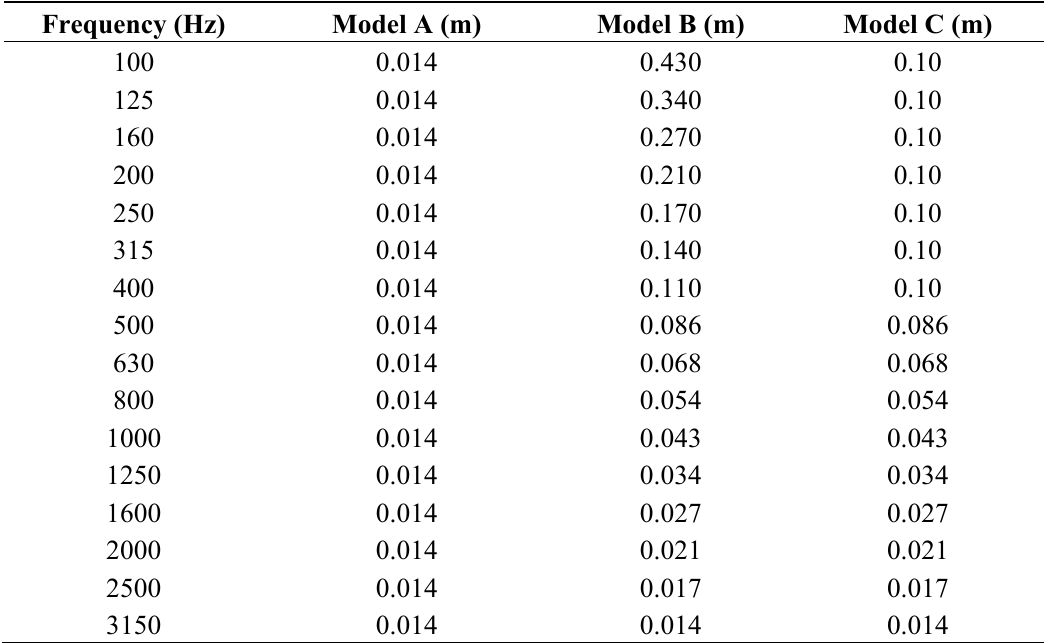
Table 3. Element size distribution with respect to frequency at one-third-octave bands.